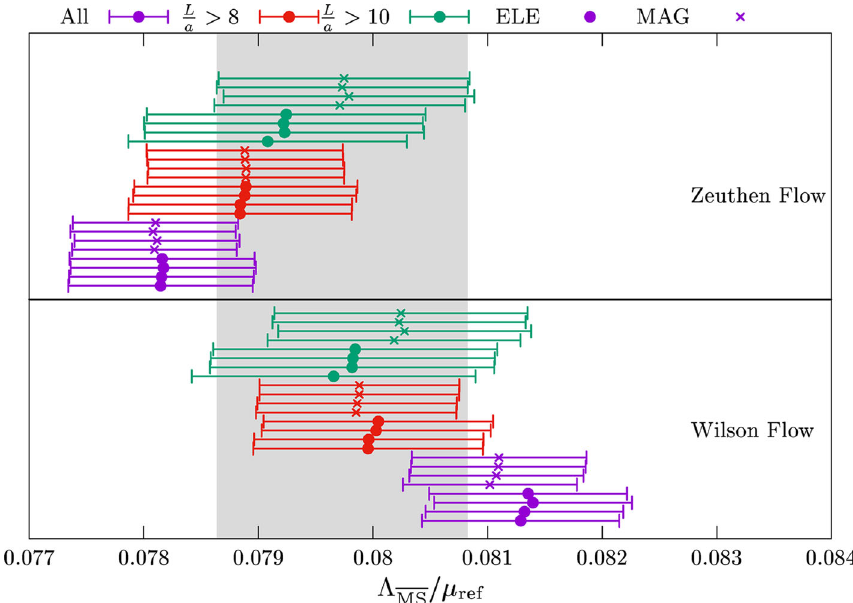
Fig. 5 Results for the ratio (cid:3) /μ ref by quoting the value MS of φ SF (α PT ) at the smaller value of the coupling α = 1 . 05 /( 4 π) ∼ 0 . 0836 ... . PT Different analysis correspond to different fits to the GF β -function as discussed in Sect.